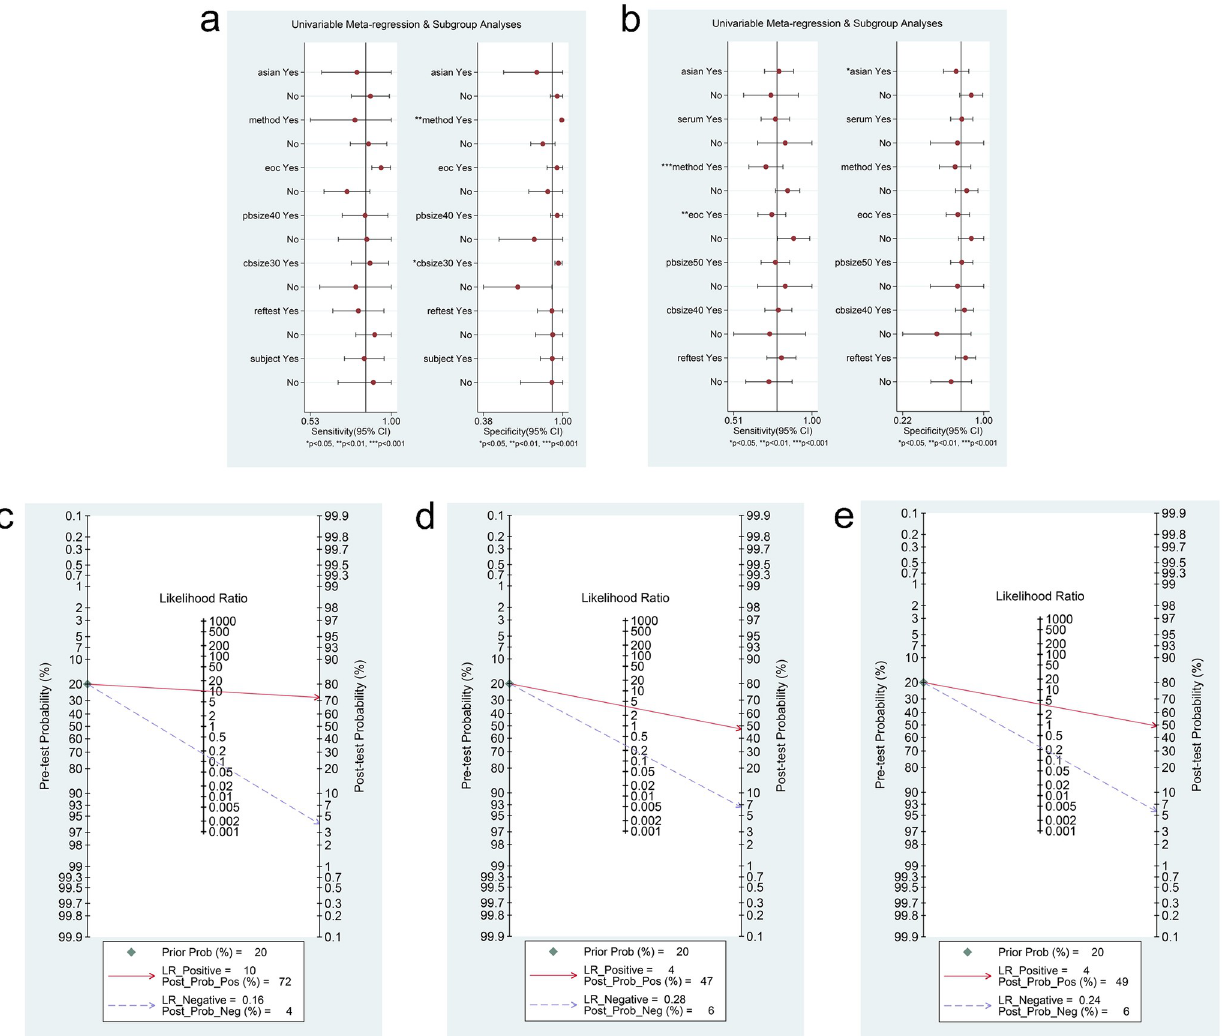
Fig 5. Meta-regression and Fagan’s Nomogram of ctDNA/miRNAs. (a) Meta-regression to explore heterogeneity between studies of ctDNA. (b) Meta- regression to explore heterogeneity between studies of miRNAs. (c) Fagan’s Nomogram to reveal the clinical application of ctDNA in the identification of OC patients and control individuals. (d) Fagan’s Nomogram to reveal the clinical application of miRNAs in the identification of OC patients and control individuals. (e) Fagan’s Nomogram to reveal the clinical application of lncRNAs in the identification of OC patients and control